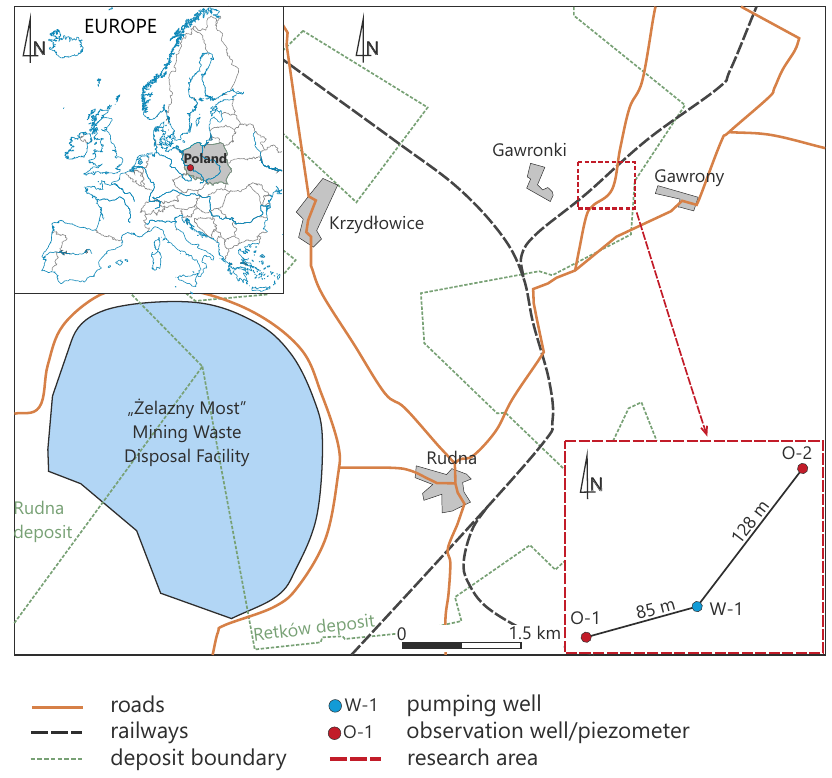
Figure 2. Location of the research area within a copper ore